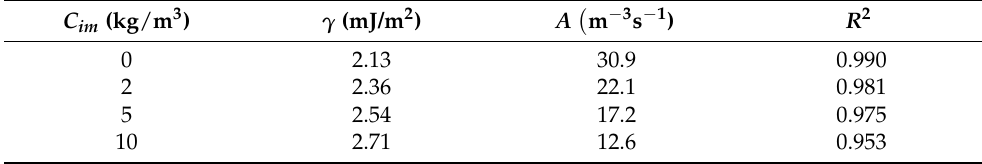
Figure 5. Plots of (𝑇 0 /∆𝑇 𝑚 ) 2 against ln(∆𝑇 𝑚 /𝑏) for various impurity concentrations, 𝐶 𝑖𝑚 ,according to Equation (9) based on the MSZW data. Table 5. Calculated values of 𝛾 and 𝐴 with the regression coefficients, 𝑅 2 , based on the MSZW Table 5. Calculated values of γ and A with the regression coefficients, R 2 , based on the MSZW data.